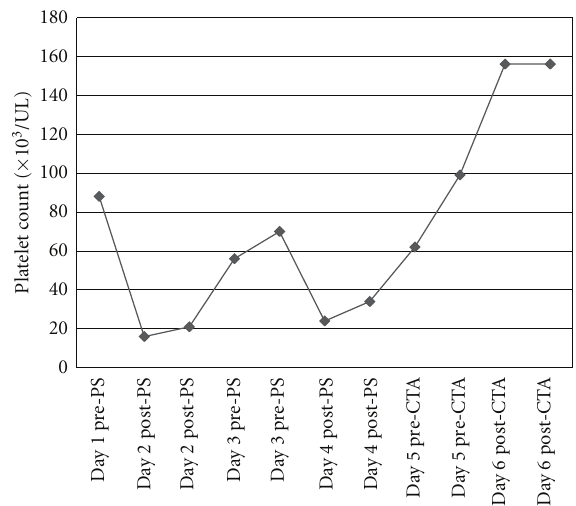
Figure 1: The trend of platelet counts before and after hemodialysis with polysulfone (PS) and cellulose triacetate (CTA) dialyzer